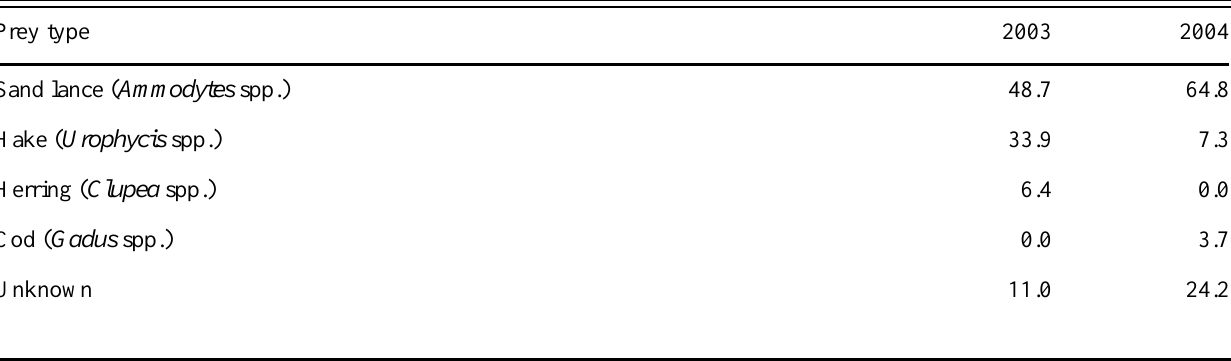
Table 1. Percentage of each prey type in the diet of Roseate Tern chicks on Country Island, Nova Scotia, Canada, in 2003 (n = 7 broods) and 2004 (n = 14 broods). Prey type Sand lance ( Ammodytes spp.) Hake ( Urophycis spp.) Herring ( Clupea